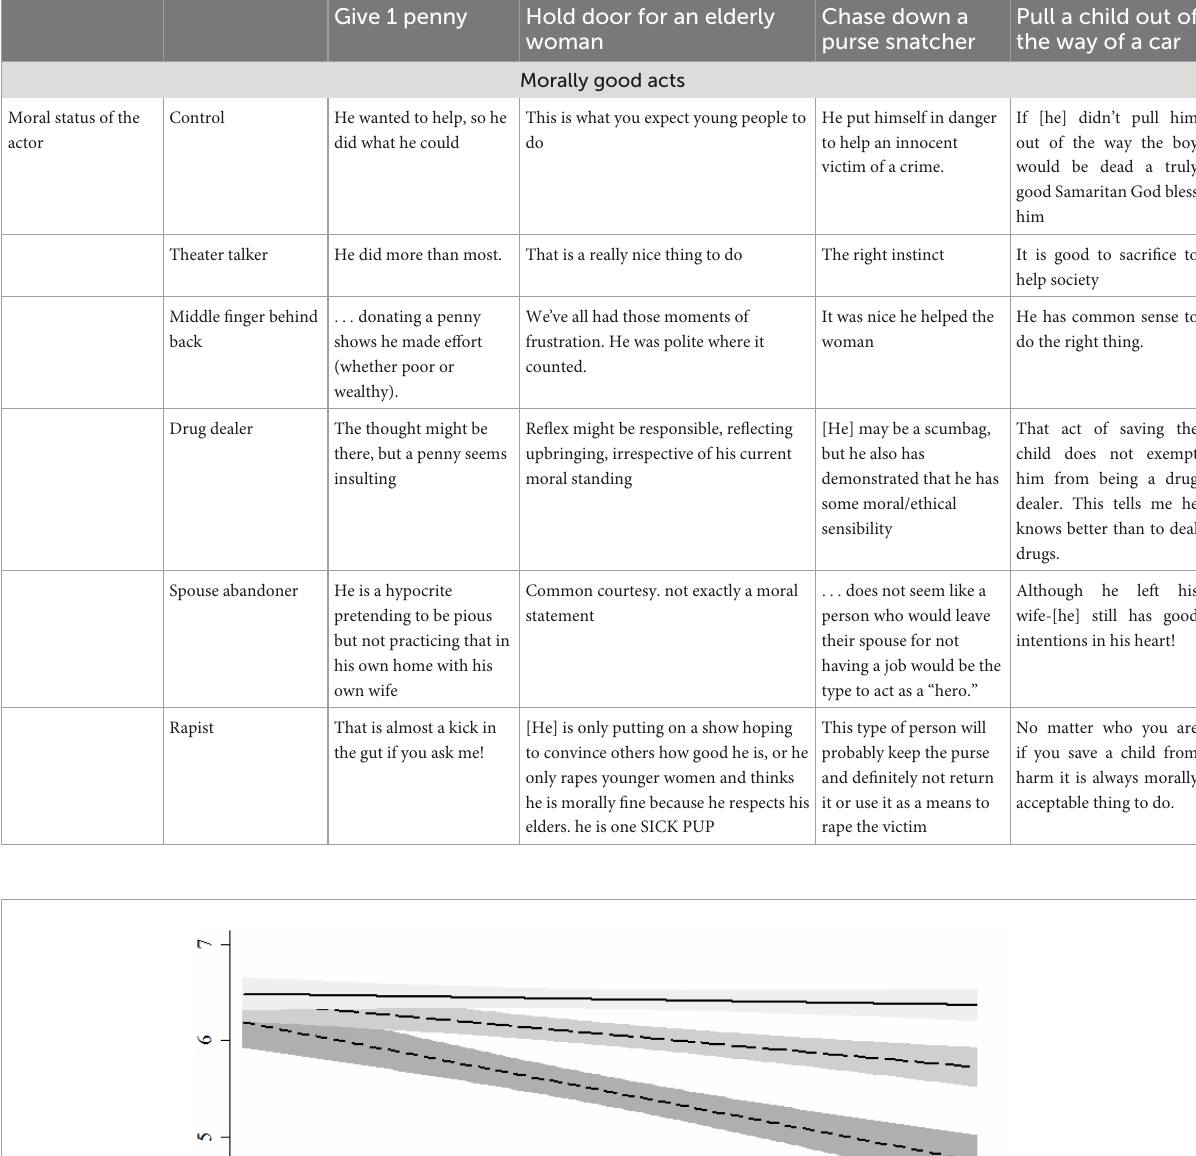
TABLE 1 Reasons participants offered for their judgments.